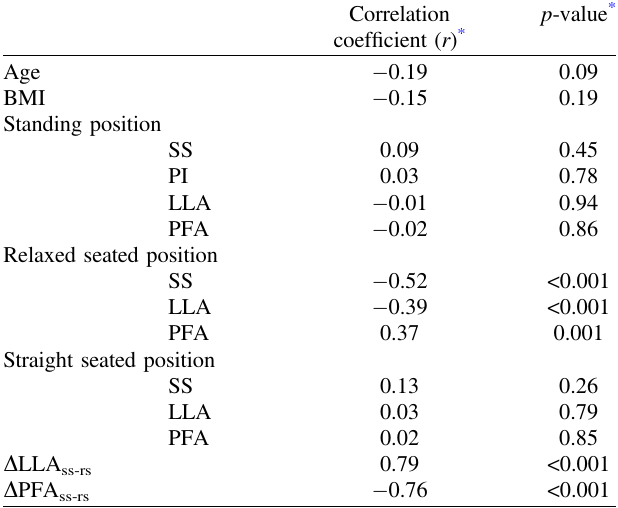
Table 2. Correlations with the change in sacral slope from the straight to the relaxed seated position ( D SS ss-rs